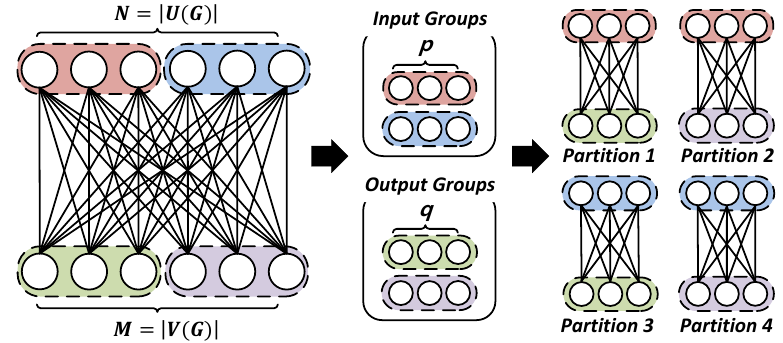
Figure 3. Vanilla Decomposition Algorithm